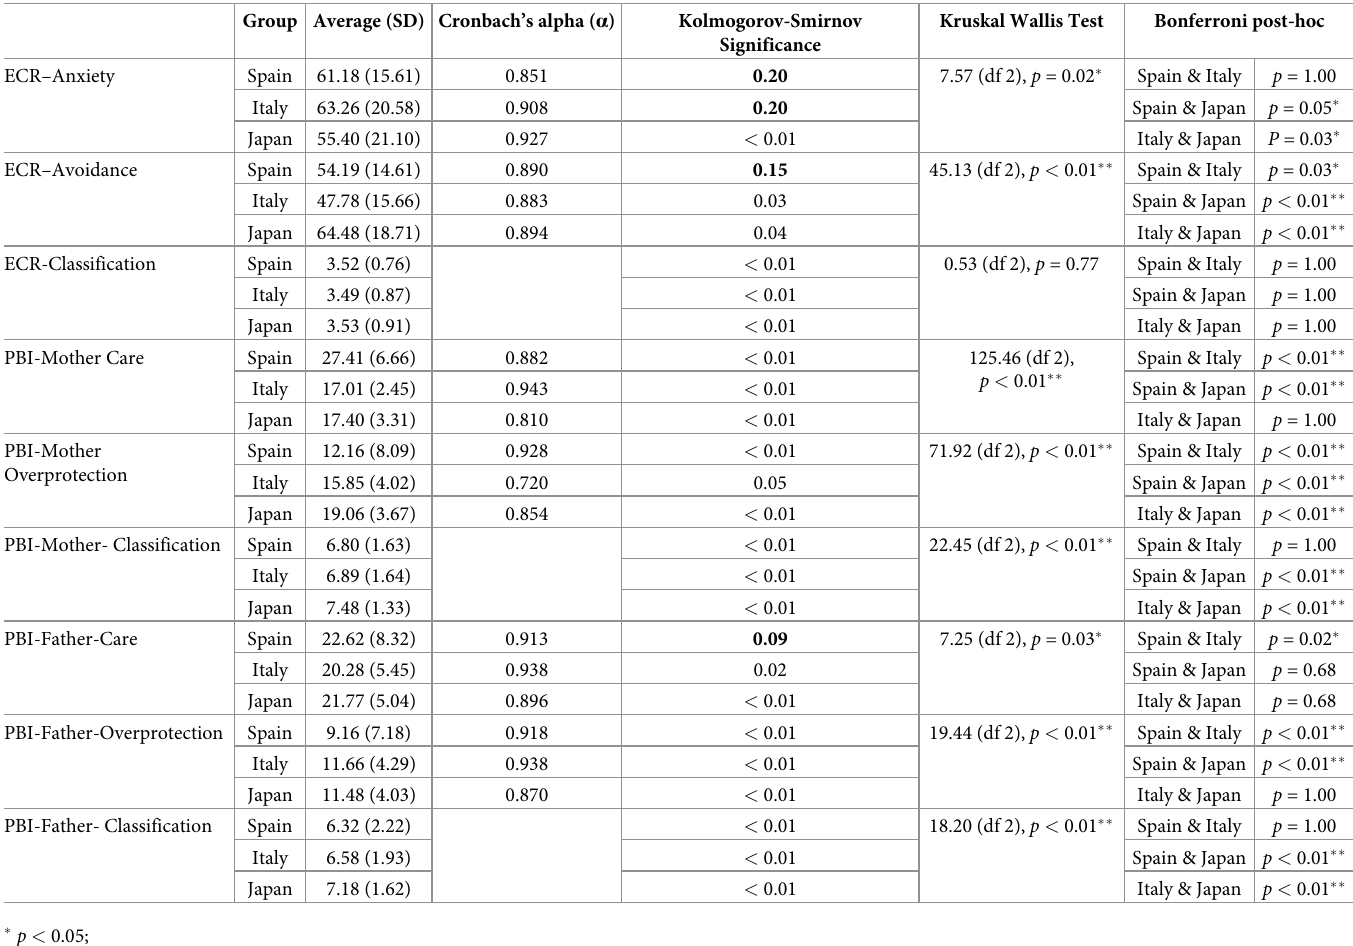
Table 3. Descriptive statistics for the ECR and PBI scales. Group Average (SD) Cronbach’s alpha ( α ) Kolmogorov-Smirnov